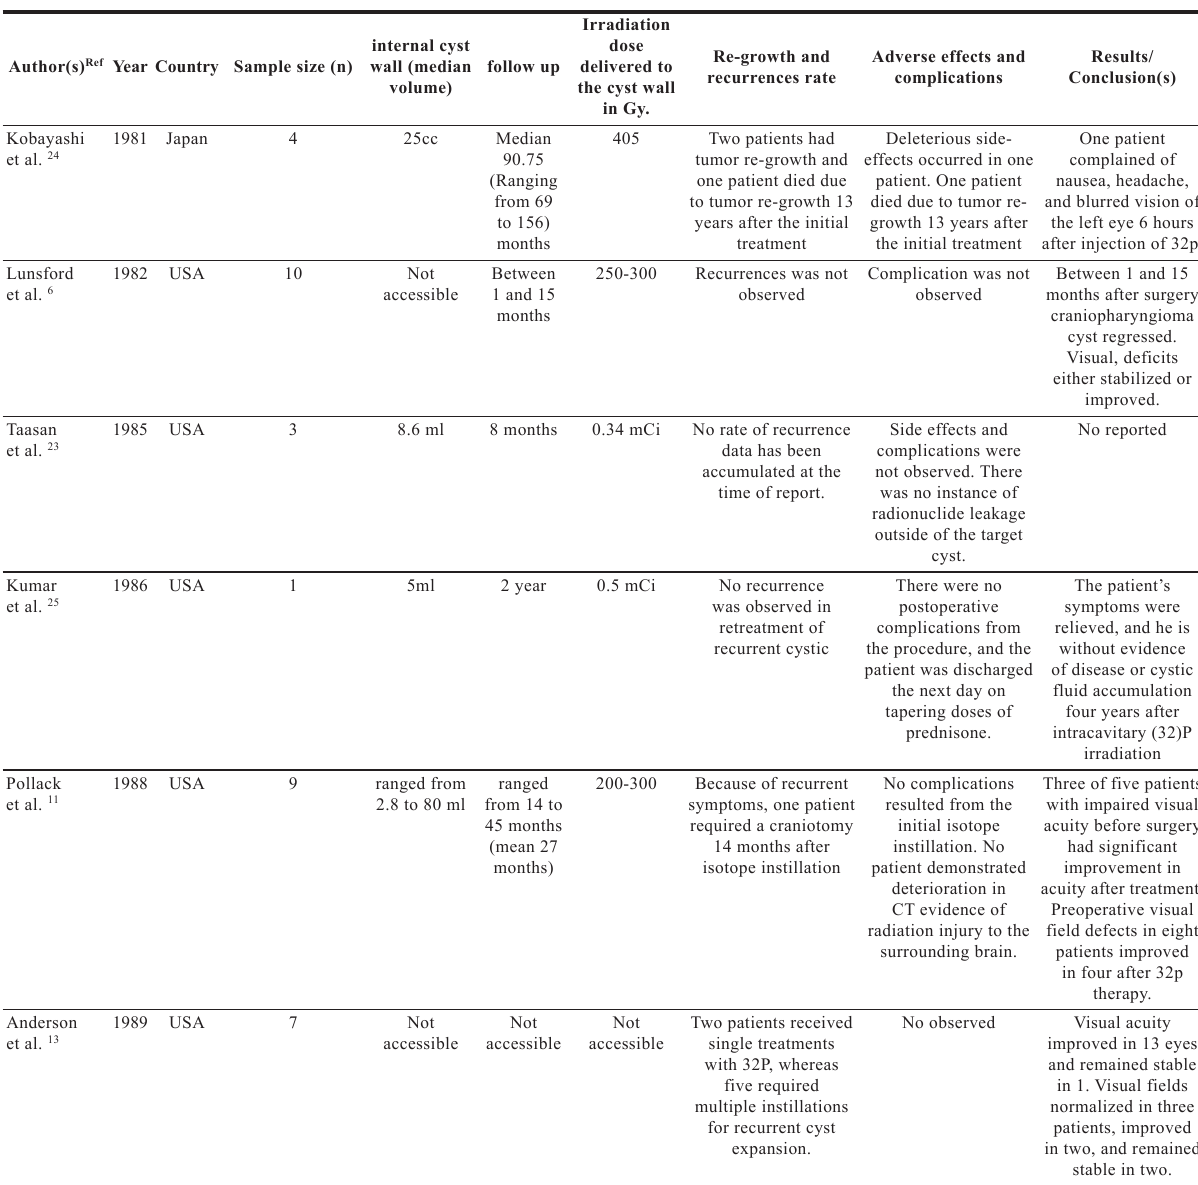
Table 1. Studies on visual outcome on intracavitary brachytherapy using stereotactically applied phosphorus-32 colloid for treatment of cystic